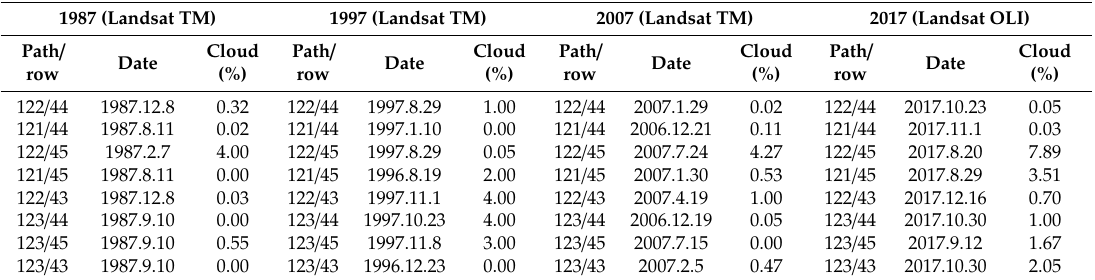
Table 1. Information on the images that were applied in the study. OLI, operational land imager; TM, thematic mapper.